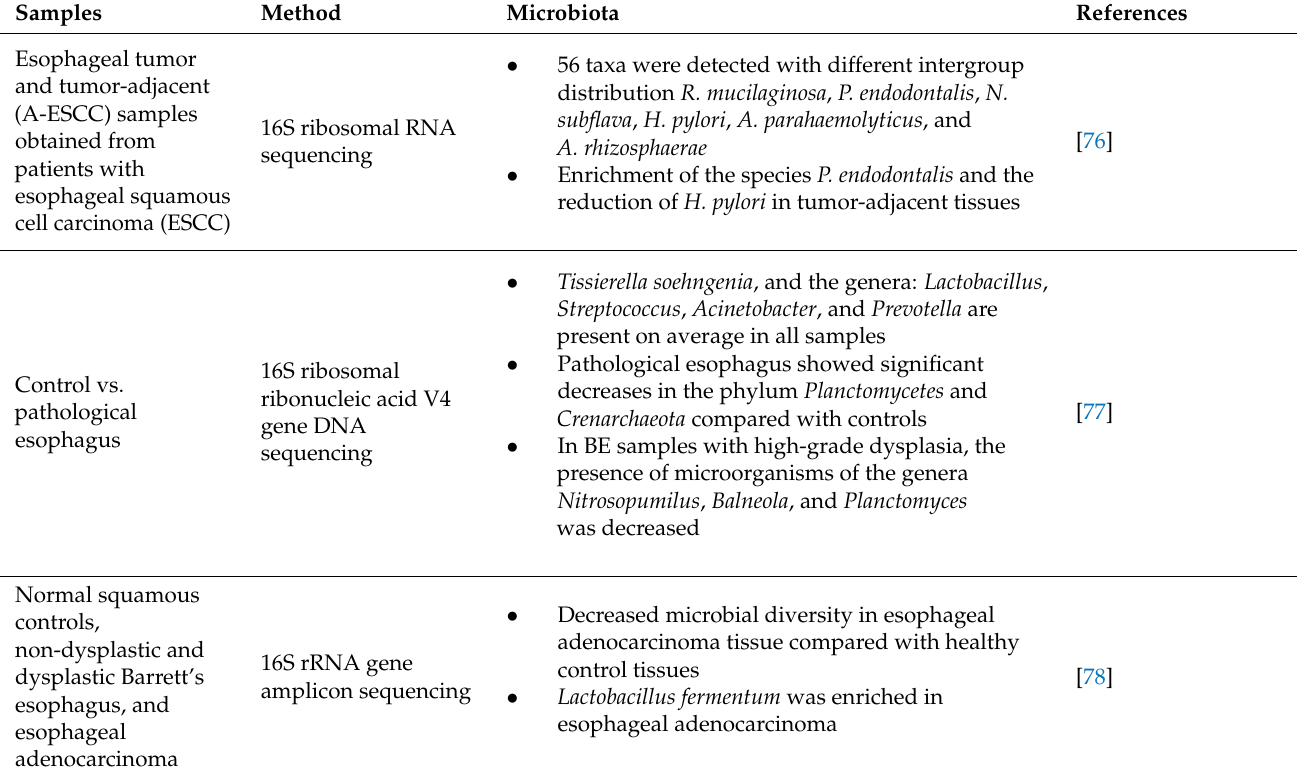
Table 2. The influence of microbiota on the development of esophageal